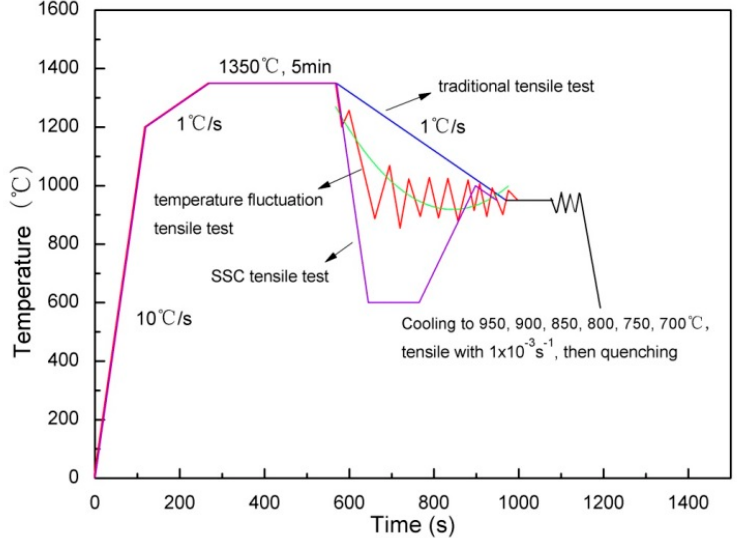
Figure 9. Different thermal schedules for tensile tests.